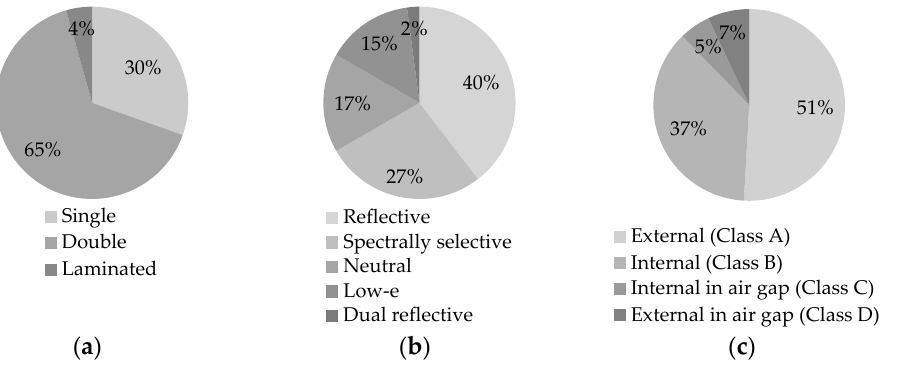
Figure 8. Type of glazing substrate ( a ) and type ( b ) and installation position ( c ) of solar control films assessed by the existing studies.